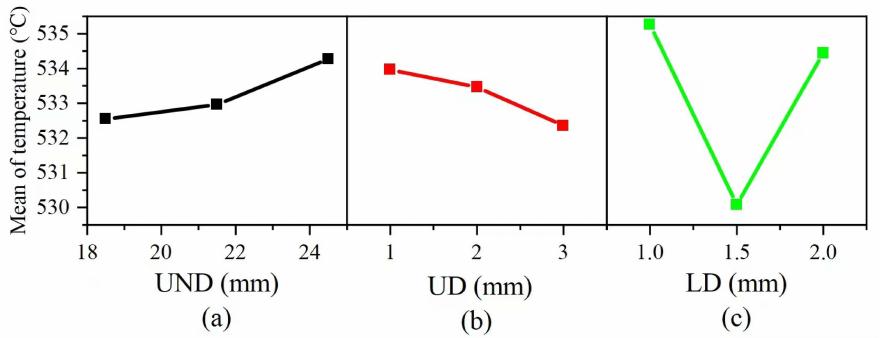
Figure 6. The diagram of main effects of the three variables on maximum temperature. ( a ) Influence of UND to maximum temperature, ( b ) Influence of UD to maximum temperature, ( c ) Influence of LD to maximum